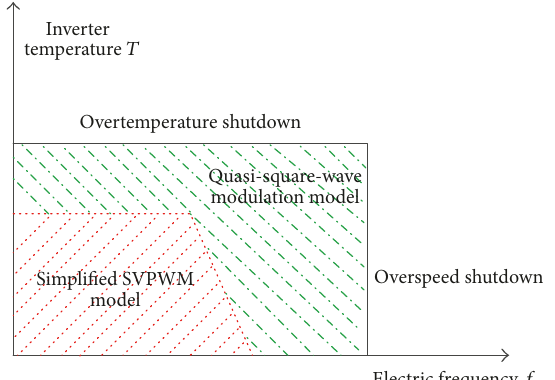
Figure 6: Temperature-frequency regional distribution with run- time of dual-mode